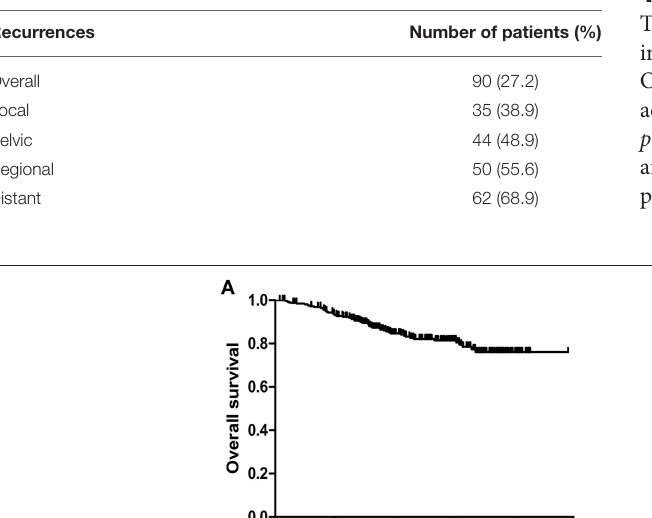
TABLE 2 | Distribution of tumor recurrences for patients with cervical cancer in VMAT group.